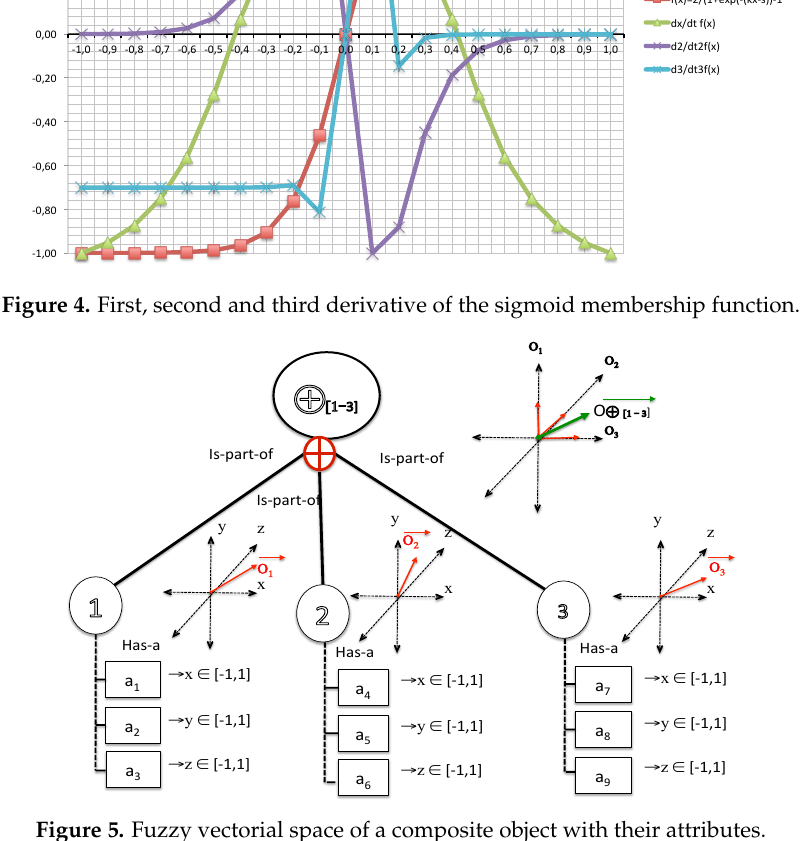
Figure 5. Fuzzy vectorial space of a composite object with their